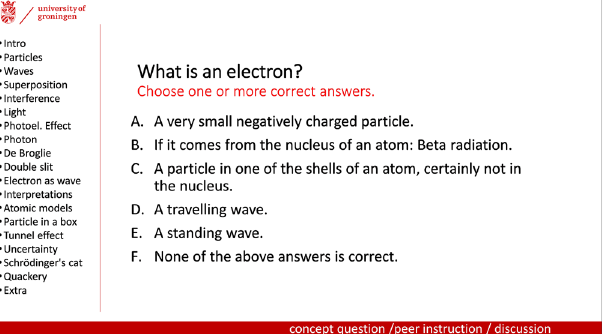
FIG. 1. Example of a slide with a concept question.